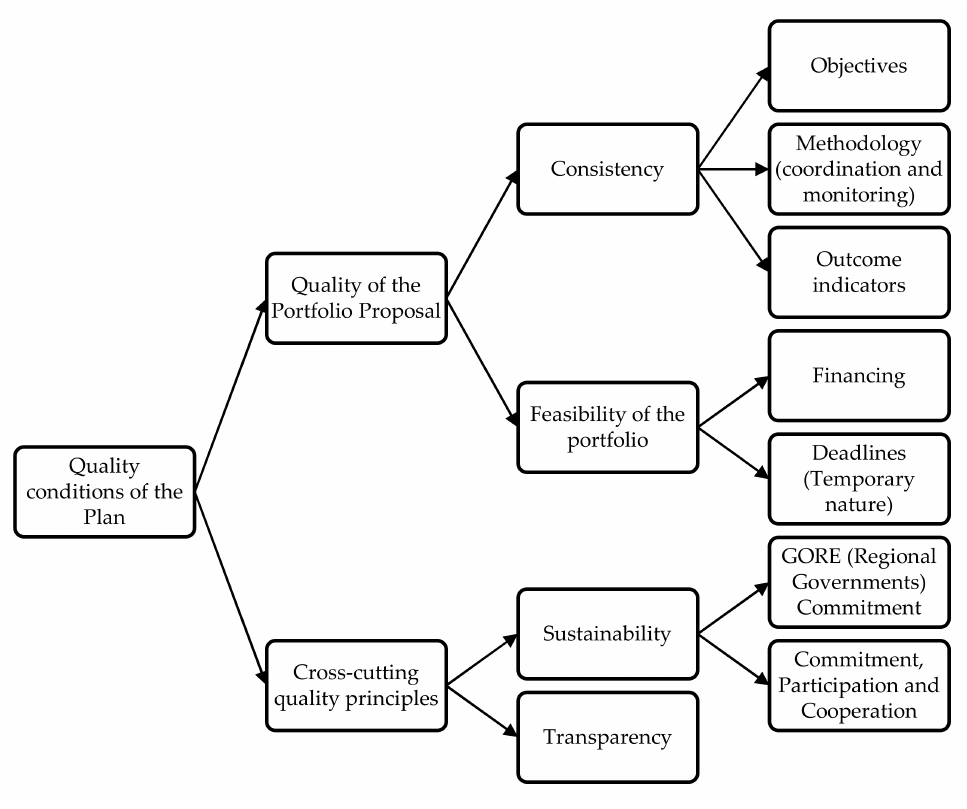
Figure 4. Criteria for the Strategic Criterion “TDP Quality Conditions”. Table 2. Definitions and forms of measurement of the sub-criteria for the Sub-criterion “Quality of the portfolio